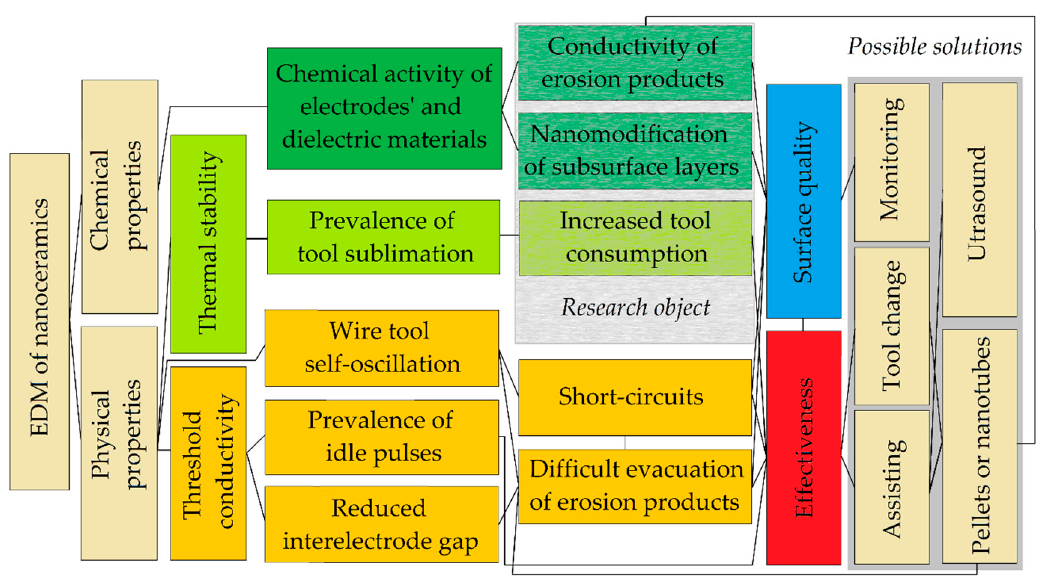
Figure 1. Current state of the obstacles that have occurred, their influence on the machinability of new materials and the quality of the obtained surfaces, the main trends in searching for solutions in the electrical discharge machining of ceramic composites and nanocomposites.